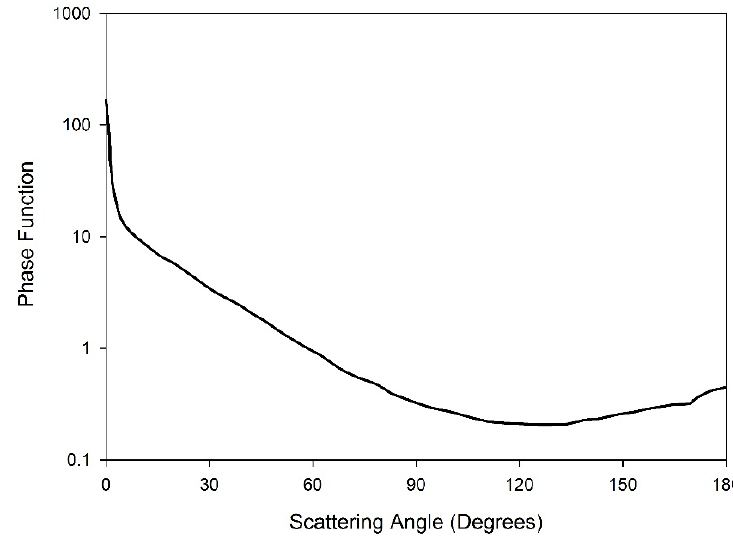
Figure 5. Plot of phase function at 550 nm for continental aerosol model (AOD = 0.5).